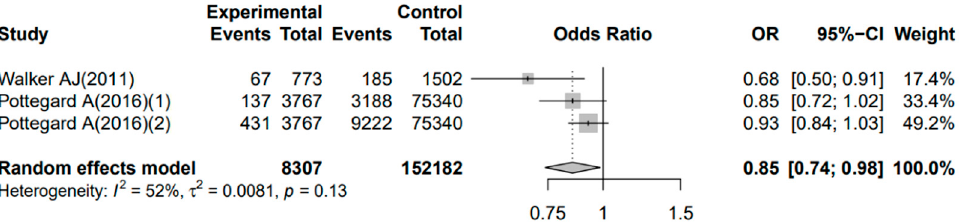
Figure 1. The association between antidepressants and the occurrence of glioma in the three case- control studies [85,86]. OR, odds ratio; CI, confidence interval.